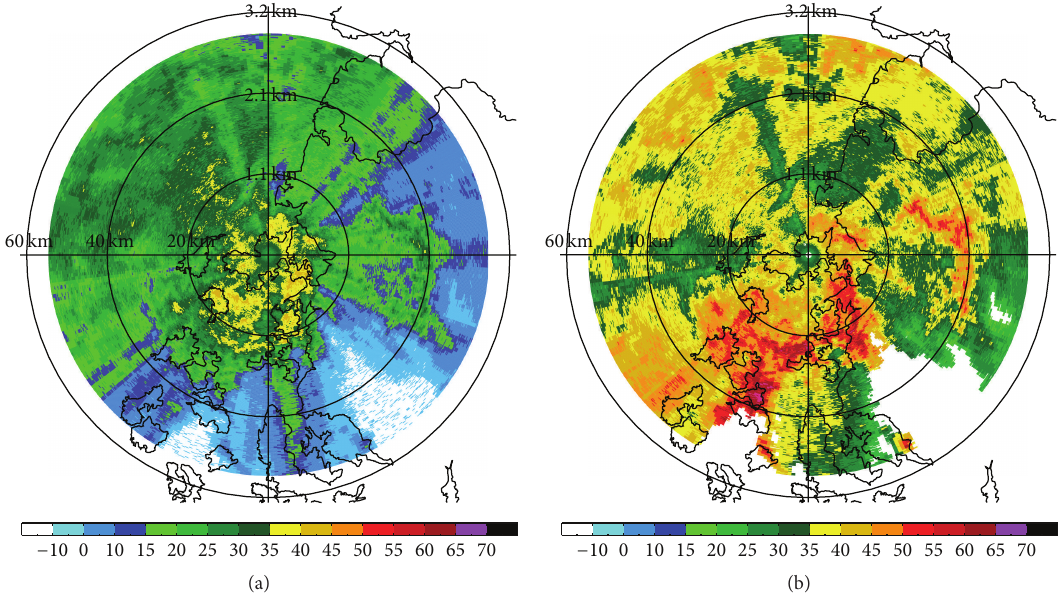
Figure 7: PPIs of measured (a) and attenuation corrected (b) 𝑍 𝐻 of the NIMS-XPOL for the case in Figure